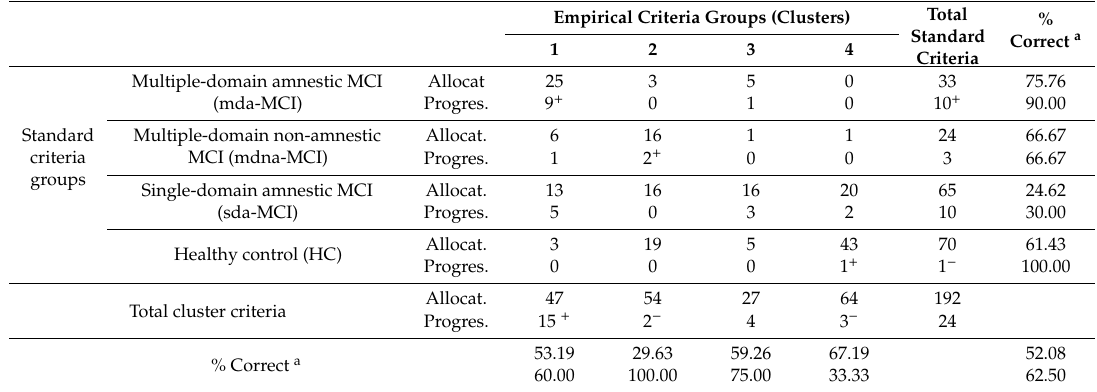
Table 4. Cross-tabulated data for standard criteria groups and empirical criteria groups (clusters). Number of participants corresponding to standard criteria groups correctly allocated to the empirical groups (Allocat.). Number of participants that progressed to probable dementia in each group (Progres.).